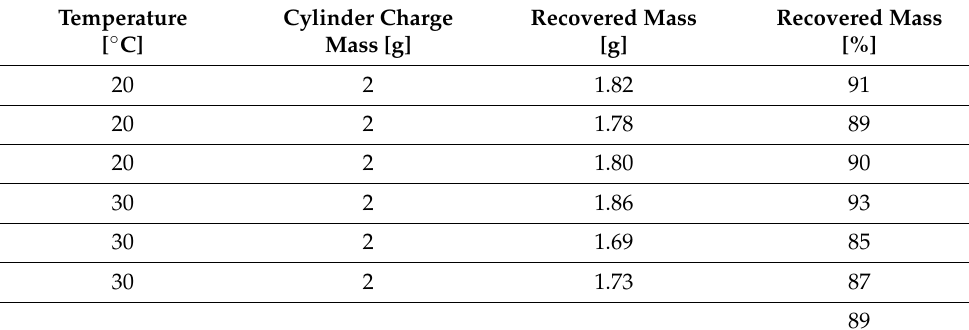
Table 9. HMX recovered from the PBX 3.